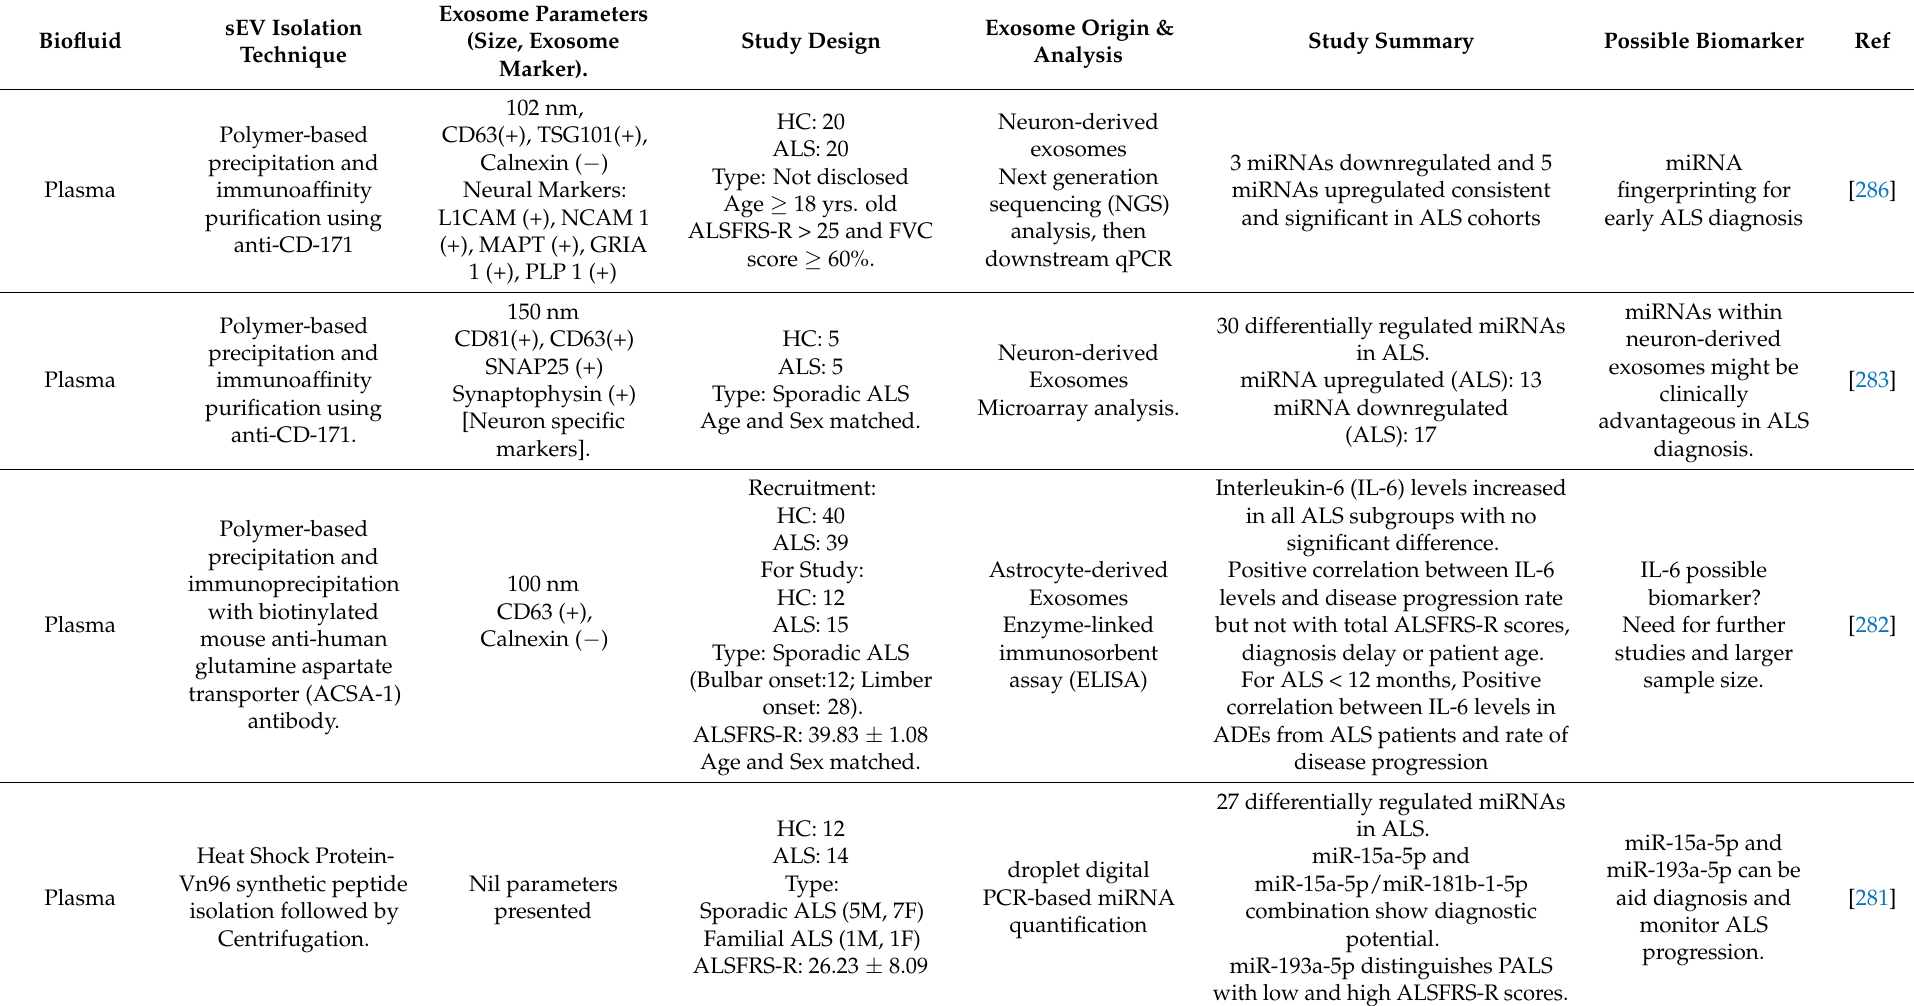
Table 4. Studies evaluating sEVs as molecular biomarkers for diagnosis in Amyotrophic lateral sclerosis